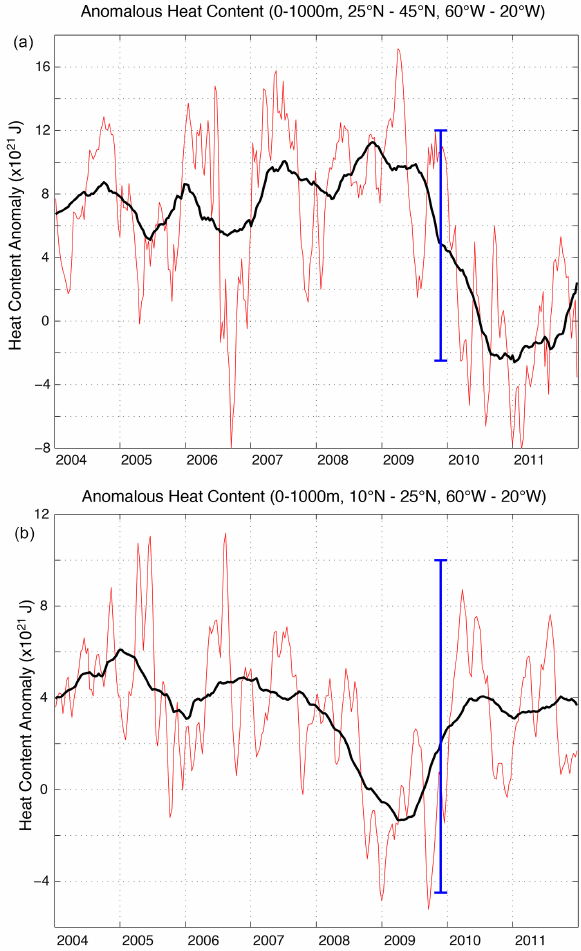
Figure 4. Anomalous heat content (a) north and (b) south of 25 ◦ N. Heat content anomaly is defined as the deviation in temperature from Hydrobase seasonal climatology multiplied by density and specific heat and integrated vertically from 0 to 1000m depth. Heat content anomaly is then integrated over 60 to 20 ◦ W and over latitude bands 25 to 45 ◦ N (north) and 10 to 25 ◦ N (south). The red curves represent 30-day average heat content and the black curves are 12-month running mean values. The blue bar represents a change in heat content of 14 . 5 × 10 21